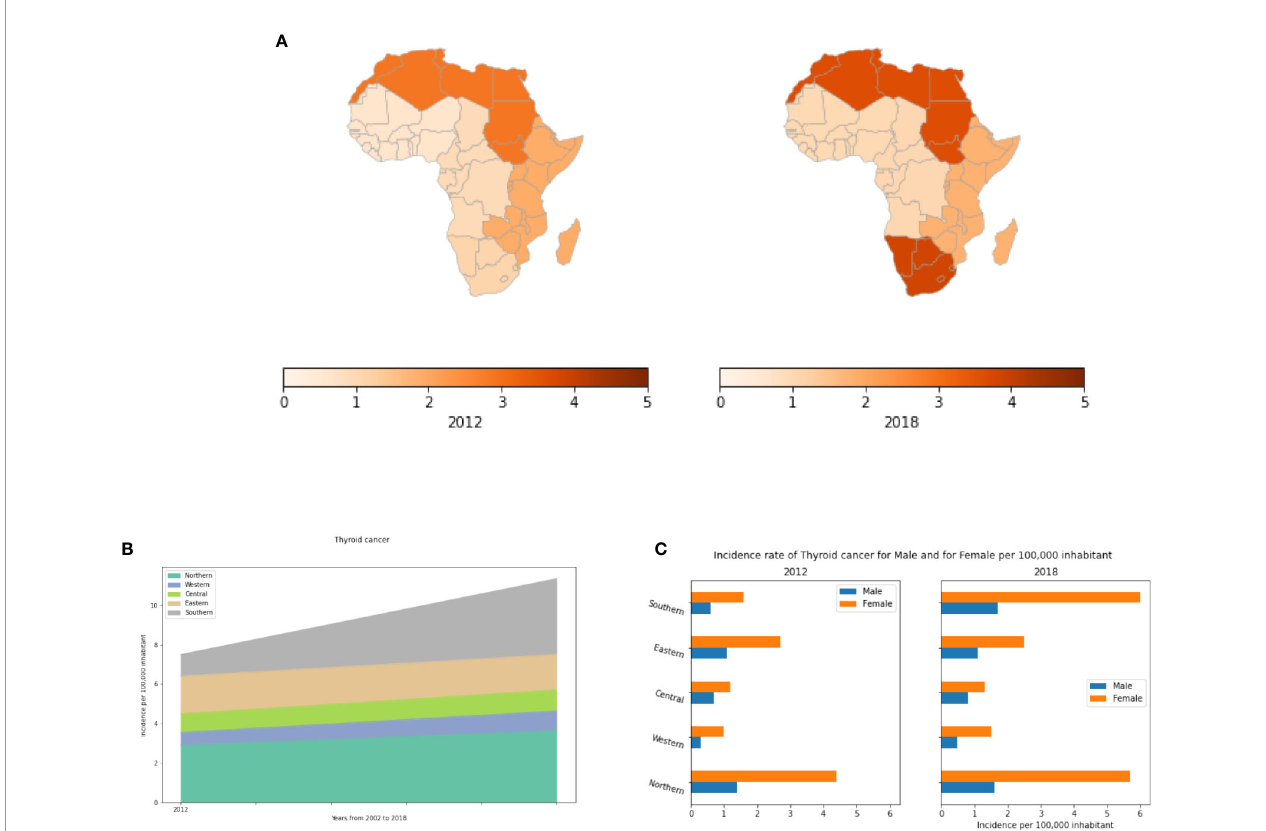
FIGURE 10 | Thyroid cancer incidence rates per year, by African region and by gender. (A) Incidence rates per 100,000 inhabitant in different African regions. (B) Dynamics of the incidence from 2012 to 2018. (C) Thyroid cancer incidence rates by gender in